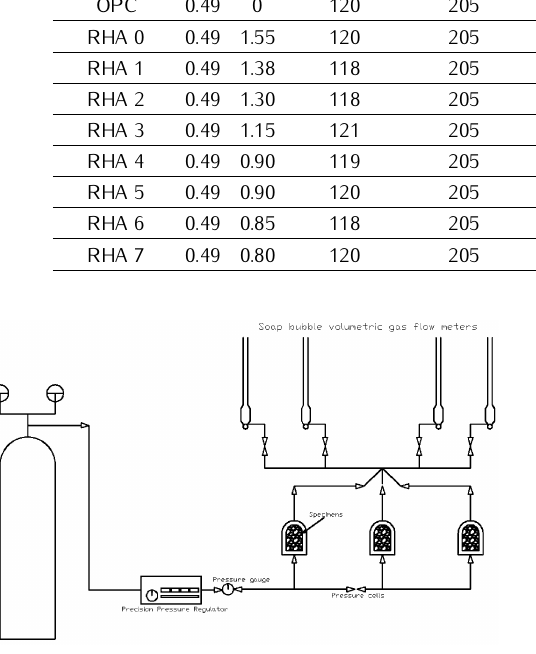
Figure 2. Experimental setup for nitrogen gas permeability test.